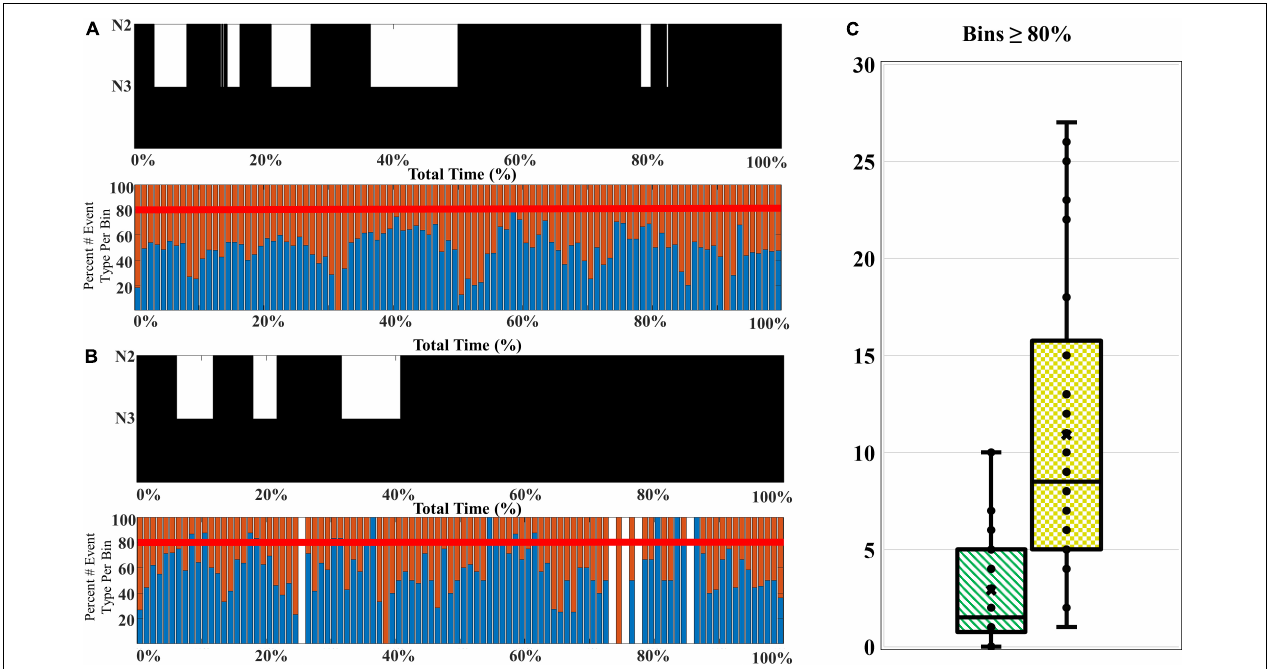
FIGURE 6 | A comparison of the SWA composition among younger and older adults. (A) A younger participant (CFS 800092), age 21-year-old, and (B) an older participant (CFS 800099), age 61-year-old, are presented as an illustrative example of SWA thresholding. The percentage of late-fast spindle/slow wave events (blue bars) and early-fast spindle/slow wave events (red bars) are assessed for bins with 80% or greater late-fast spindle/slow wave composition. (C) The number of bins at or exceeding 80% late-fast spindle/slow wave composition for each participant is quantified, and the younger adults (green-stripes; n = 30) are compared to older adults (yellow-checkered; n = 30) at the group